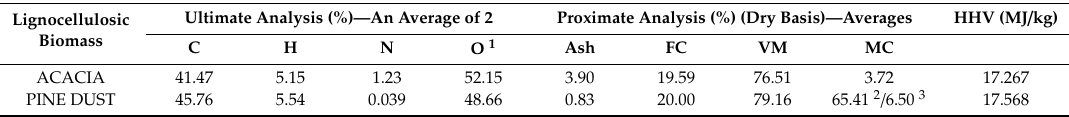
Table 3. Results of ultimate and proximate analyses (dry basis) for acacia, compared to the common pine. FC—fixed carbon, VM—volatile matter and MC—moisture